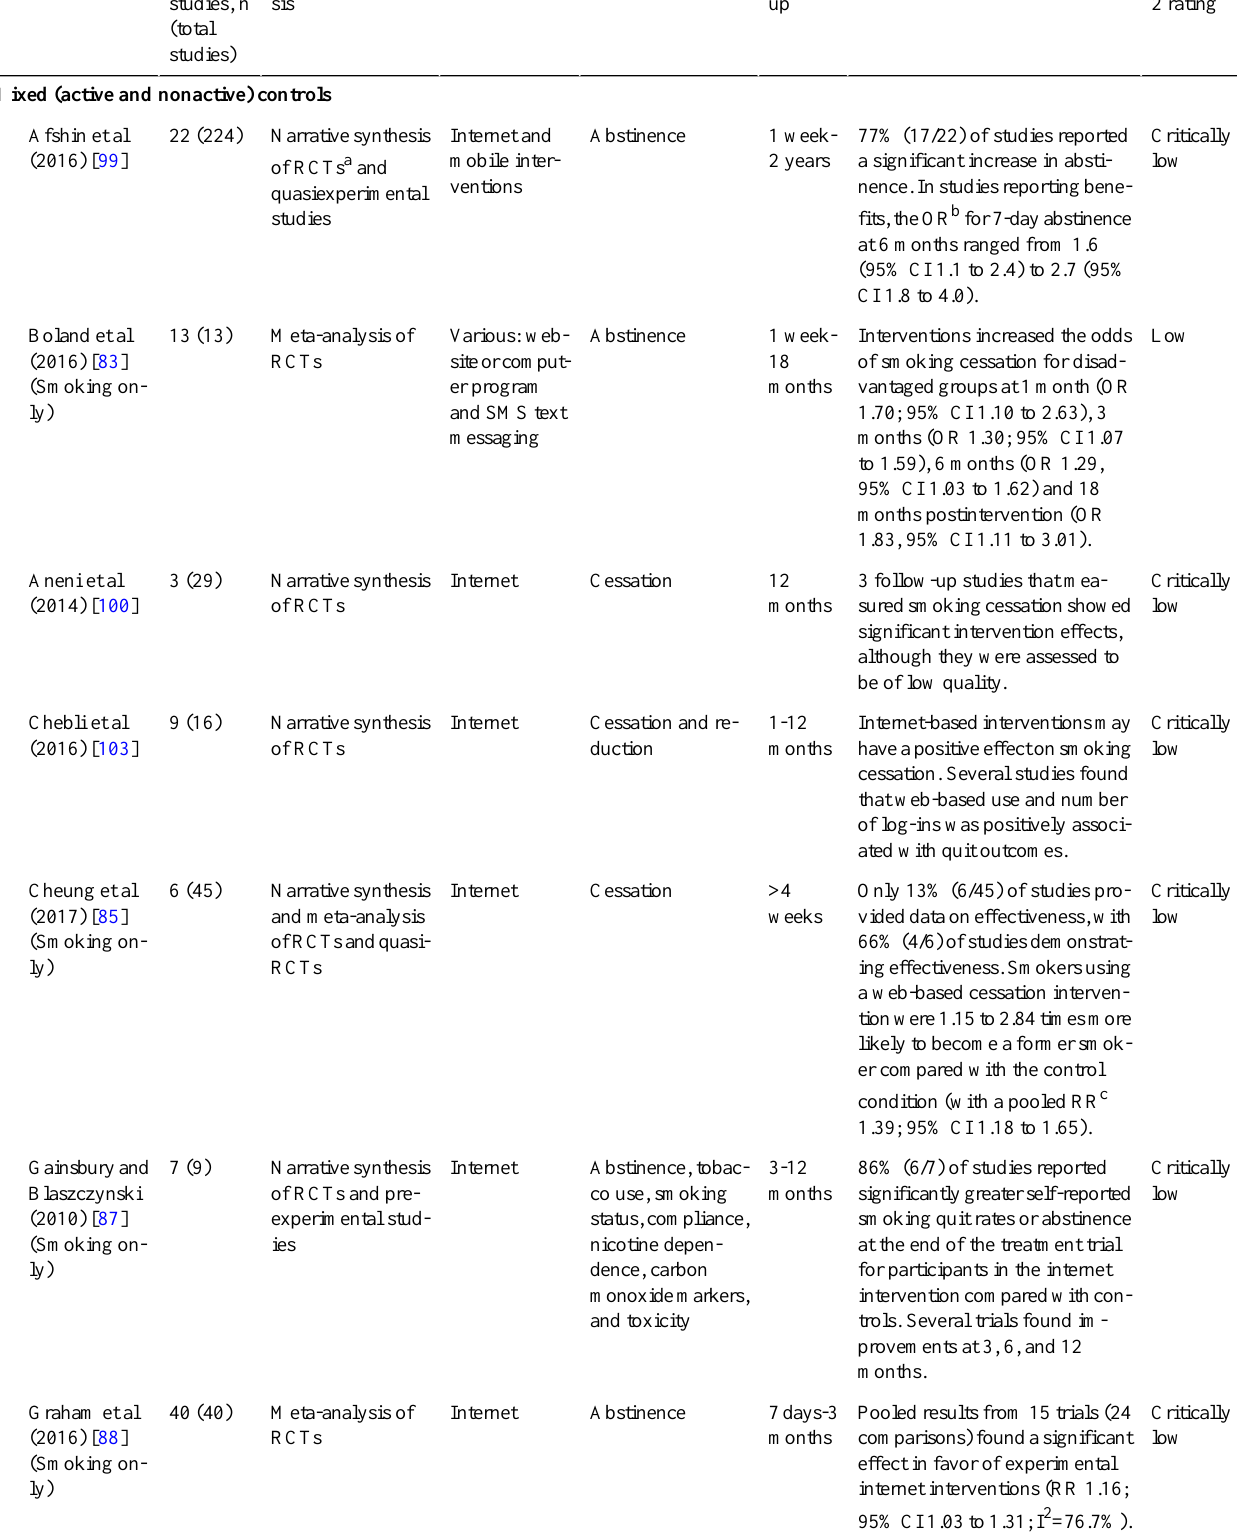
Table 6. Results of reviews on smoking, ordered by type of control and further ordered by mode of delivery of intervention.